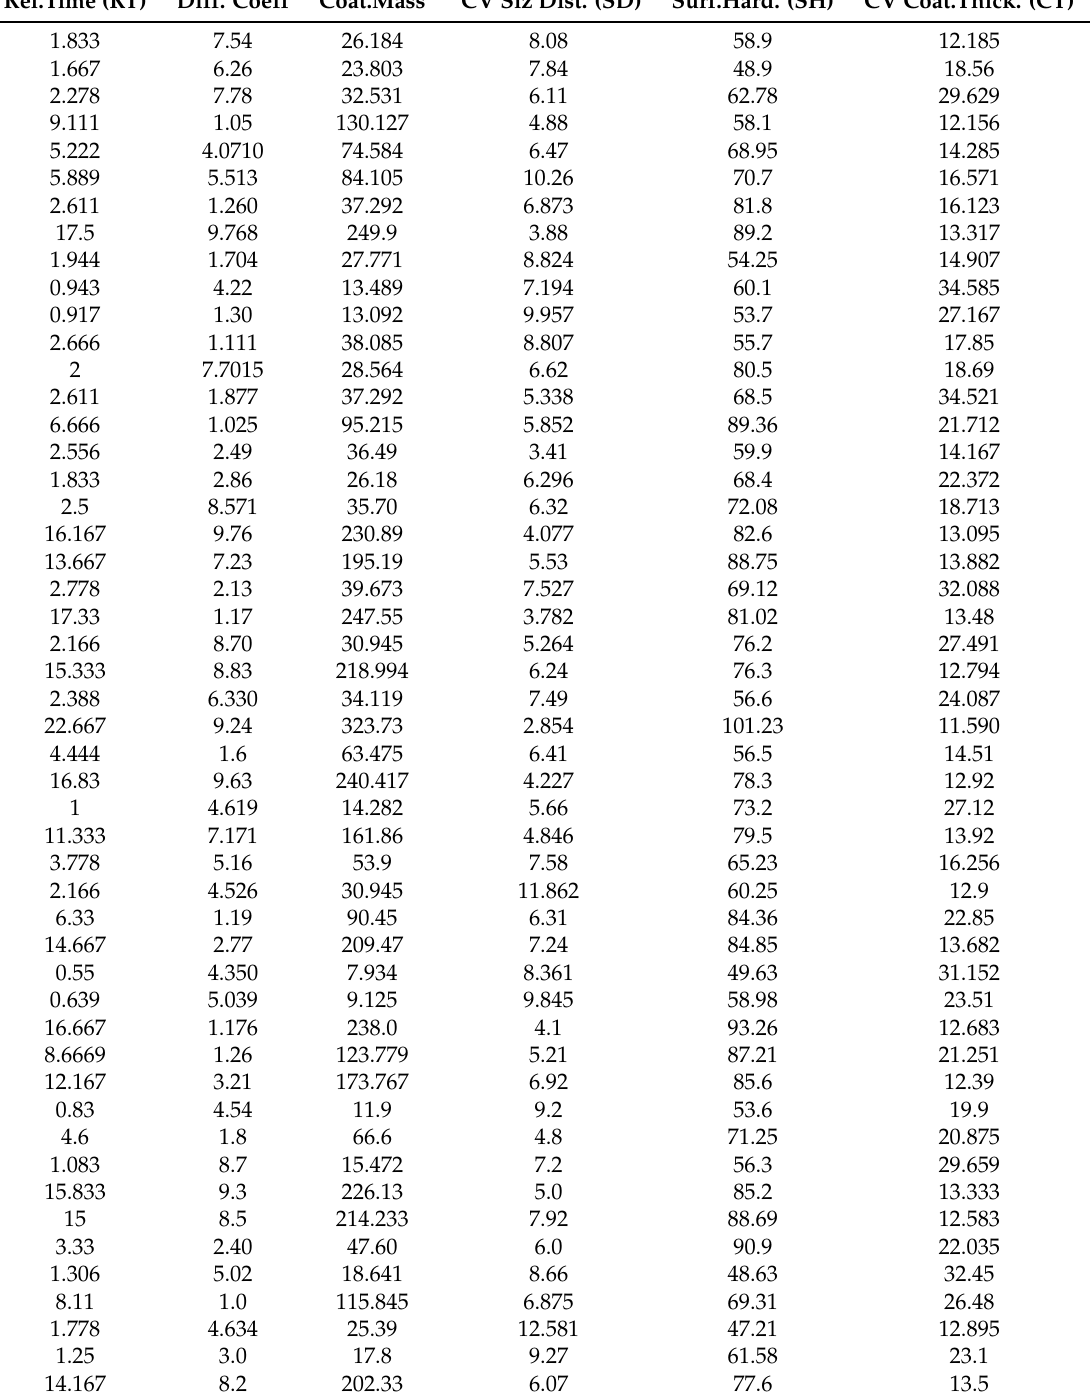
Table 3. Experimental data utilized to develop machine learning